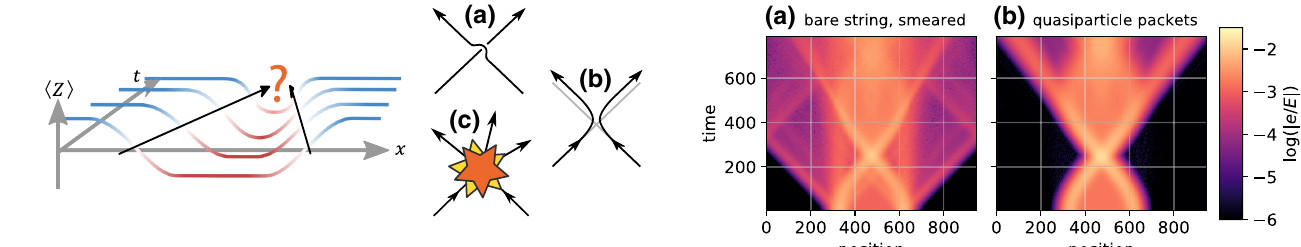
FIG. 1. Sketch illustrating the relaxation of a false-vacuum bubble in a spin chain. The magnetization (cid:2) Z (cid:3) is positive in the true vacuum, but negative in the false vacuum. A bubble- wall collision is a scattering process, which may be (a) free (no interaction), (b) elastic (no particle production), or (c) inelastic (particle production). Note that in free and elastic scattering of topological particles the left (right) particle always remains a kink (antikink).